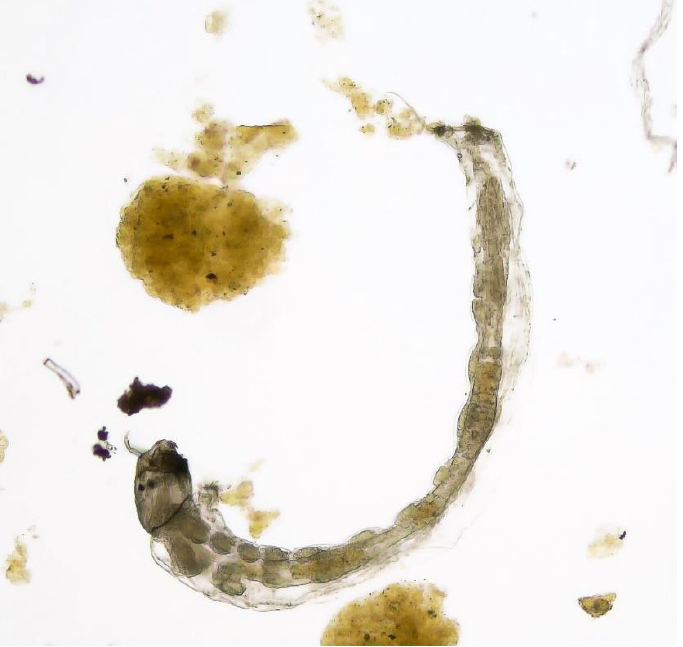
Figure 1. Paratanytarsus grimmii larva from a drinking water network, 5 mm long: Figure Michels © .